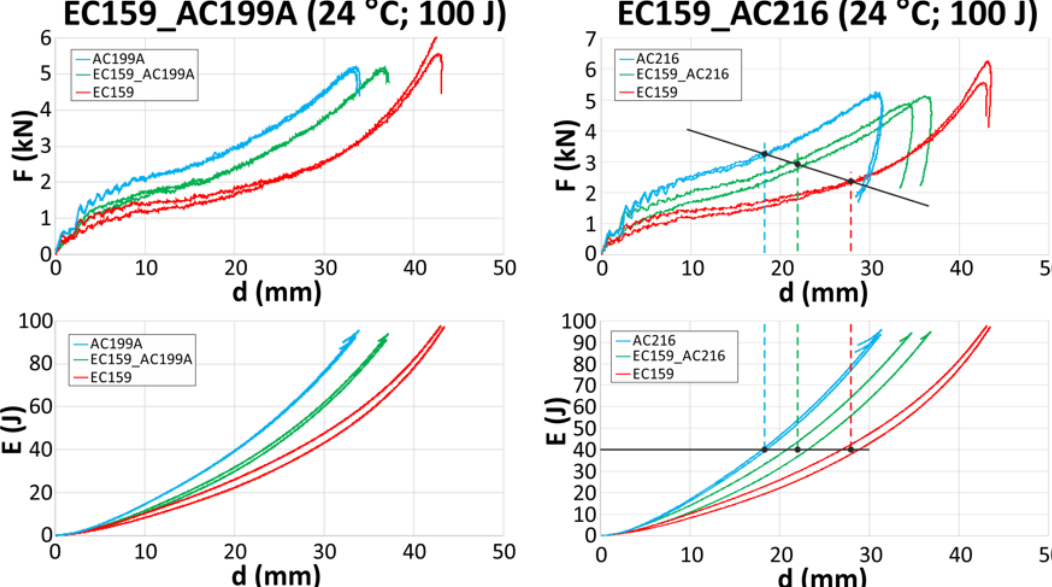
Figure 4. Force-displacement (upper row) and energy-displacement (lower row) curves of tested cork sandwiches for EC159_AC199A (left column) and EC159_AC216 (right